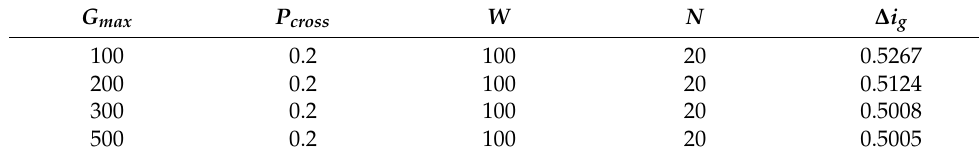
Table 5. Obtained results from the sensitivity test considering G = 5.